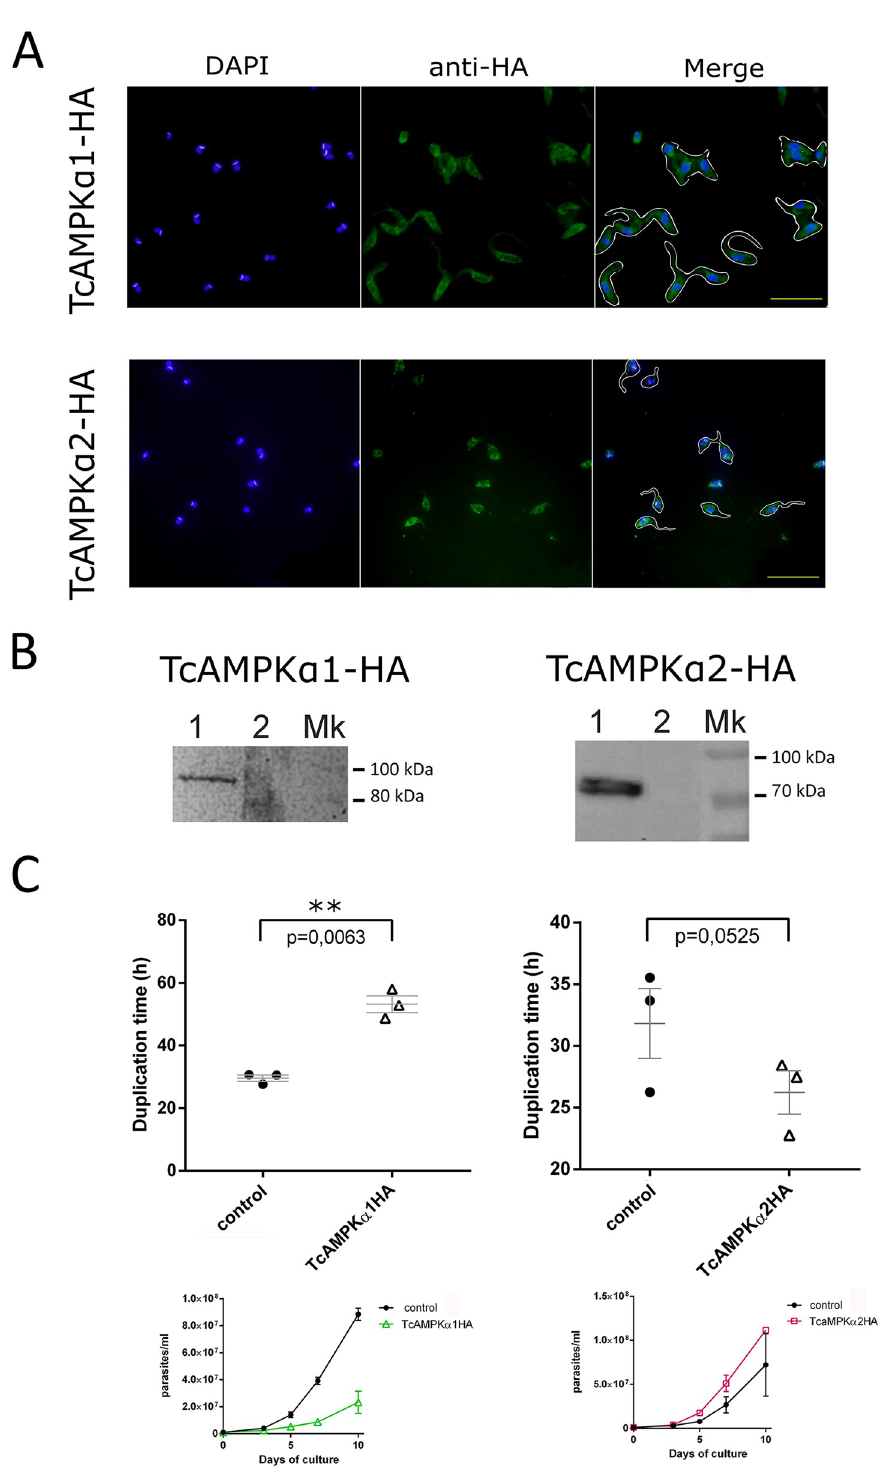
Fig 5. Over-expression of TcAMPK α isoforms in epimastigotes leads to antagonistic effects in proliferation. ( A ) Immunofluorescence images showing the cytoplasmic expression of the constructs. In the Merge quadrants some cells were contoured to illustrate the morphology of the parasites. Scale bar = 50 μ m. (B) ( B ) Western blot of protein extracts of epimastigotes showing the correct expression of the TcAMPK α 1 and TcAMPK α 2 subunits tagged to HA. Lanes 1 of both gels show the corresponding subunit detected by the anti-HA antibody and lanes 2 correspond to